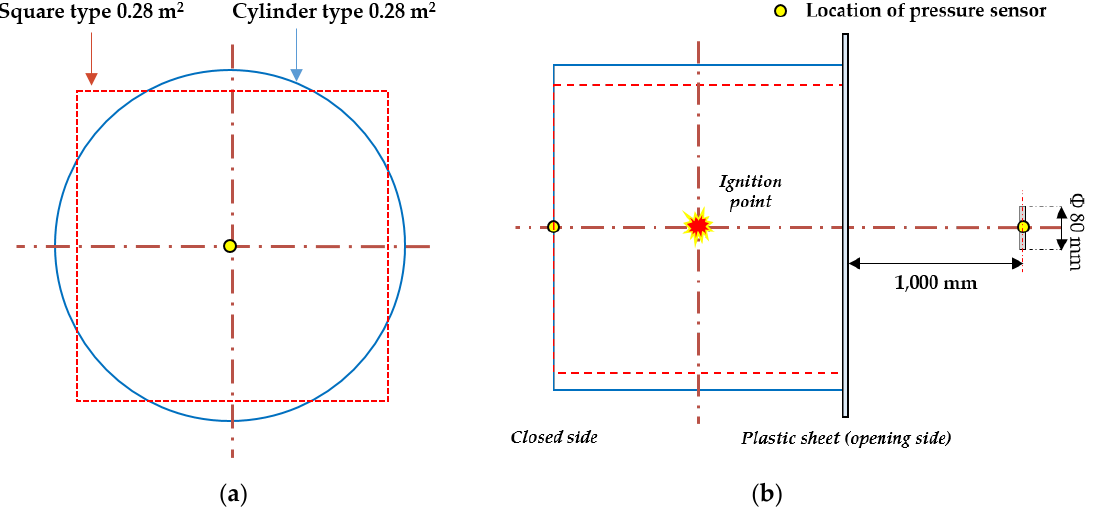
Figure 5. Location of sensors; ( a ) section view, ( b ) plane view.